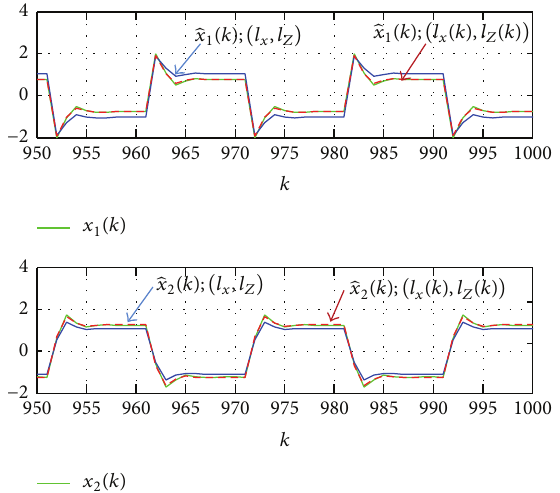
Figure 5: The output variances 𝜎 𝑦 and 𝜎 𝑒2 = 0.05 .